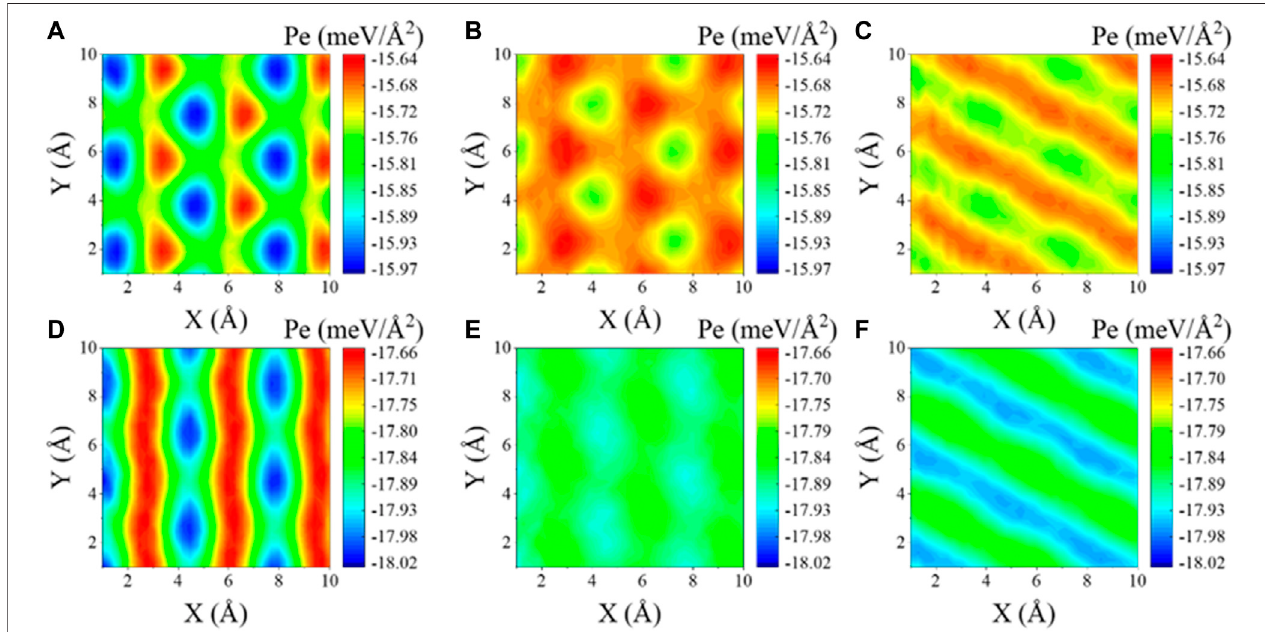
FIGURE 4 | Effective interaction potential energy surface of the heterostructure. (A – C) Potential energy surface (PES) of graphene/MoS 2 heterostructure with different rotation angles, where (A) θ = 0 ° ; (B) θ = 15 ° ; (C) θ = 30 ° ; (D – F) PES of graphene/NbSe 2 heterostructure with different rotation angles, where (D) θ = 0 ° ; (E) θ = 15 ° ; (F) θ = 30 °